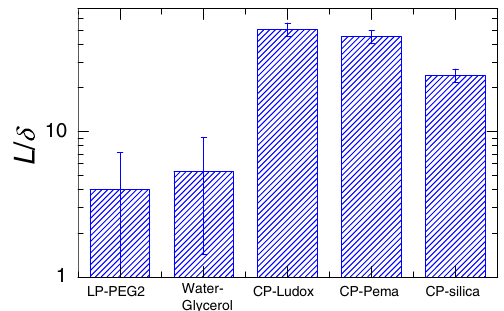
FIG. 3. Ratio L= δ obtained by fitting the data shown in Fig. 2(b) with Eq. (10). Large values of L= δ are obtained for CP samples where interfaces are probed on a time scale shorter than the diffusion-driven relaxation time of the